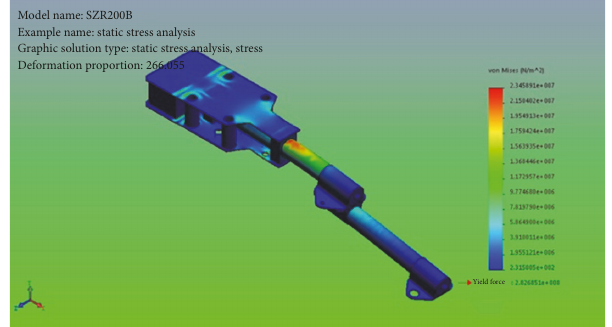
Figure 13: Finite element stress analysis of the robot.